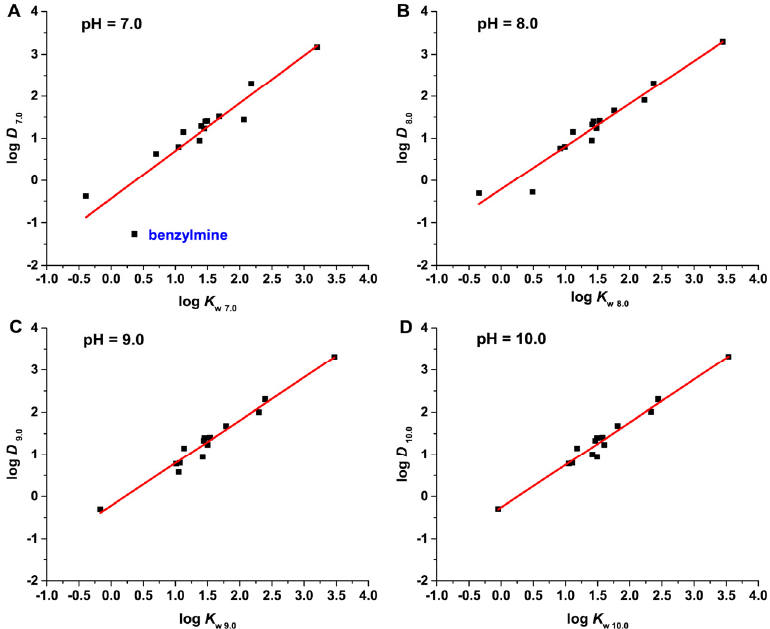
Figure 1. Linear plots of log D versus log k w for model compounds 1 – 14 at different mobile phase pH values. ( A ) pH = 7.0; ( B ) pH = 8.0; ( C ) pH = 9.0; ( D ) pH = 10.0.